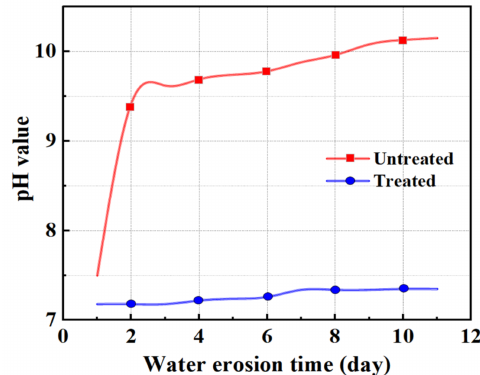
Figure 7. Comparison of pH values during the steel slag water erosion process.